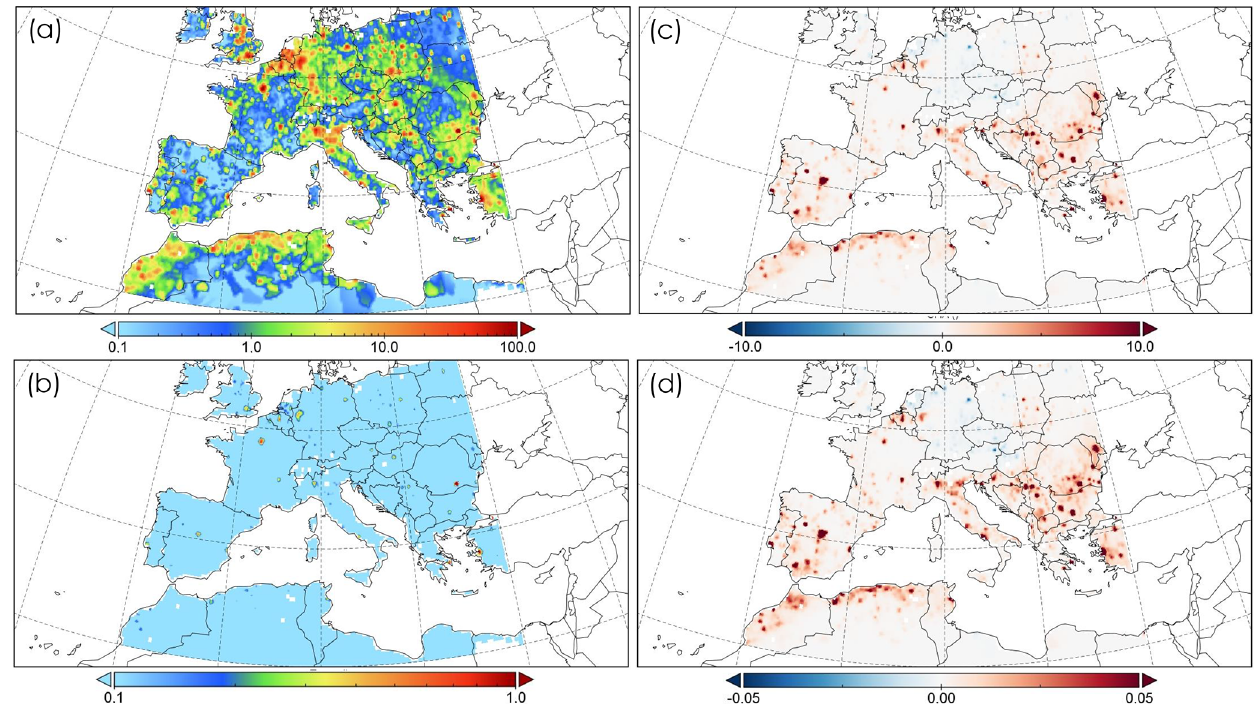
Figure 3. (a) Present cases of cerebrovascular hospital admissions (CHA) and (b) associated costs, in millions of euros. (c) Changes projected in CHA cases and (d) changes in costs (millions of euros) under the RCP8.5 scenario (2071–2100).